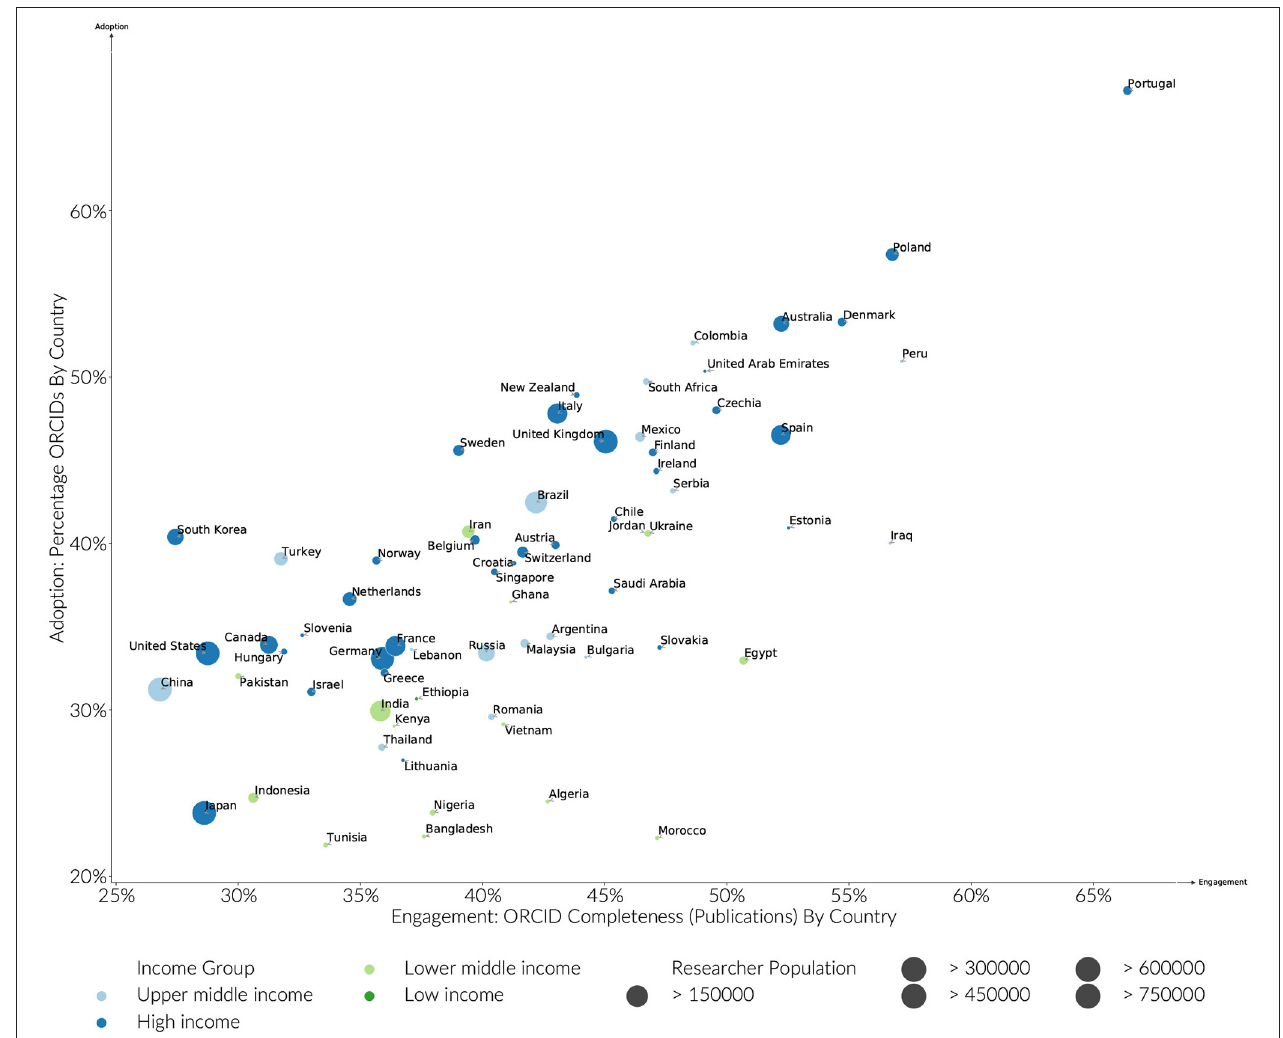
FIGURE 2 | Estimated ORCID adoption and engagement by country. Active researchers in the analysis must have (A) published between 2015 and 2019, (B) have a publication history of greater than 5 years, and (C) published more than 5